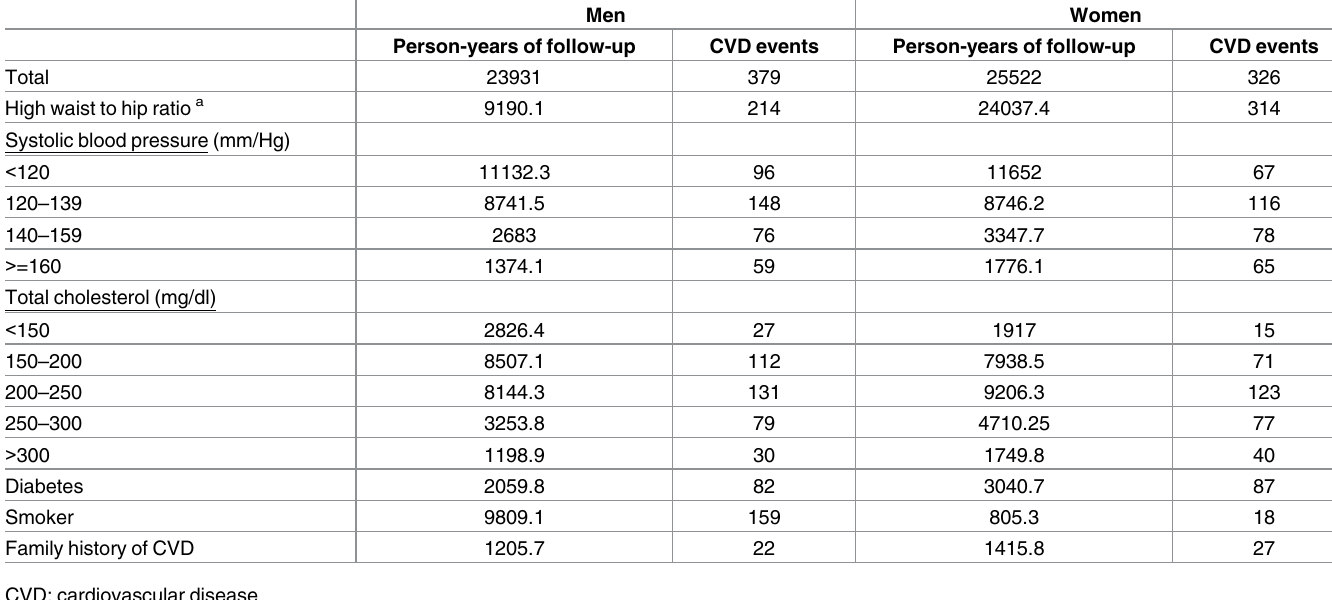
Refitted and recalibration of Framingham function The CVD risk factor regression coefficients and HRs were estimated from sex-specific ICS regression models, using the same variables as those in the Framingham function (Table 3). During the discriminatory analysis, the AUROC was 0.730(95% CI, 0.703–0.757) and 0.754 Table 2. Person-years of follow-up and CVD events according to risk factors in men and women, ICS, 2001–2011. Men Women Person-years of follow-up CVD events Person-years of follow-up CVD events Total 23931 379 25522 326 High waist to hip ratio a 9190.1 214 24037.4 314